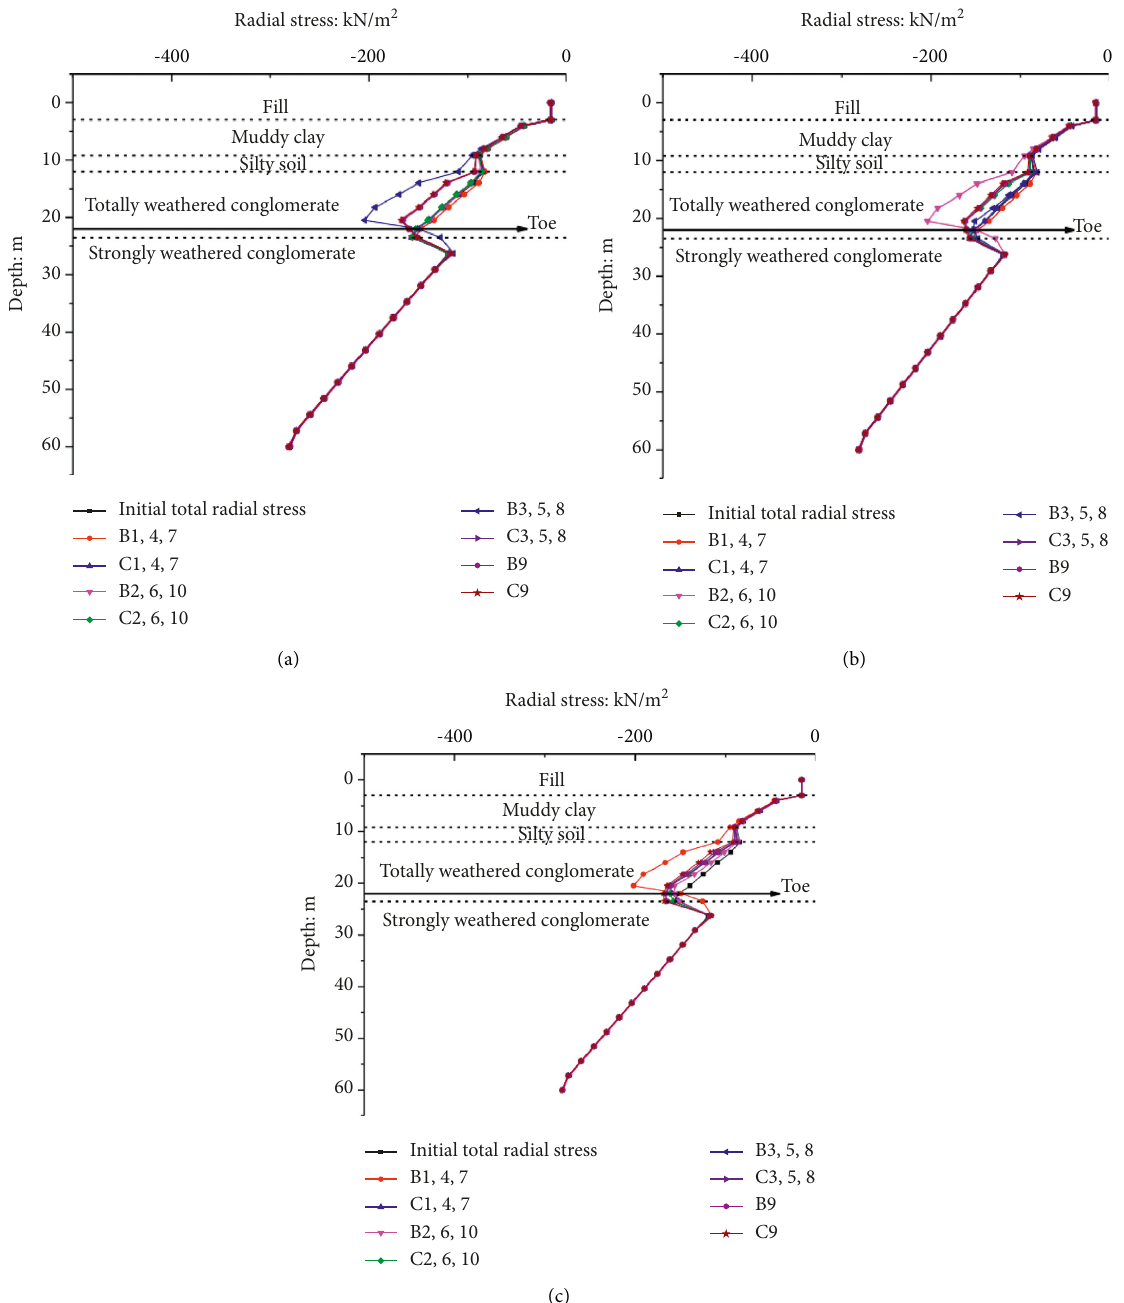
Figure 9: Radial stress distribution with depth for various stages of panel construction: effect of position of gutter. (a) Behind Gutter 5. (b) Behind Gutter 6. (c) Behind Gutter